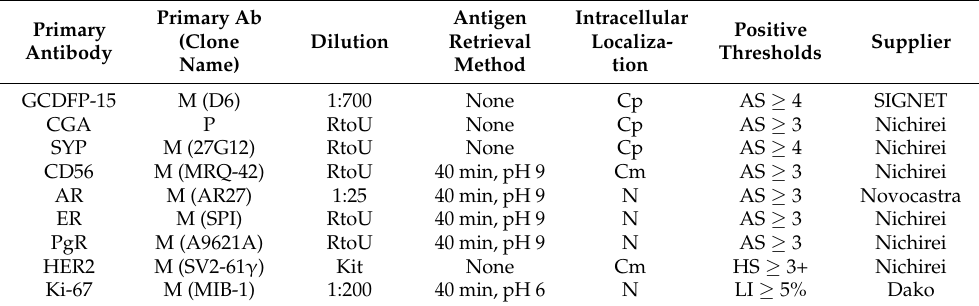
Table 1. Experimental conditions for immunohistochemistry of breast mucinous